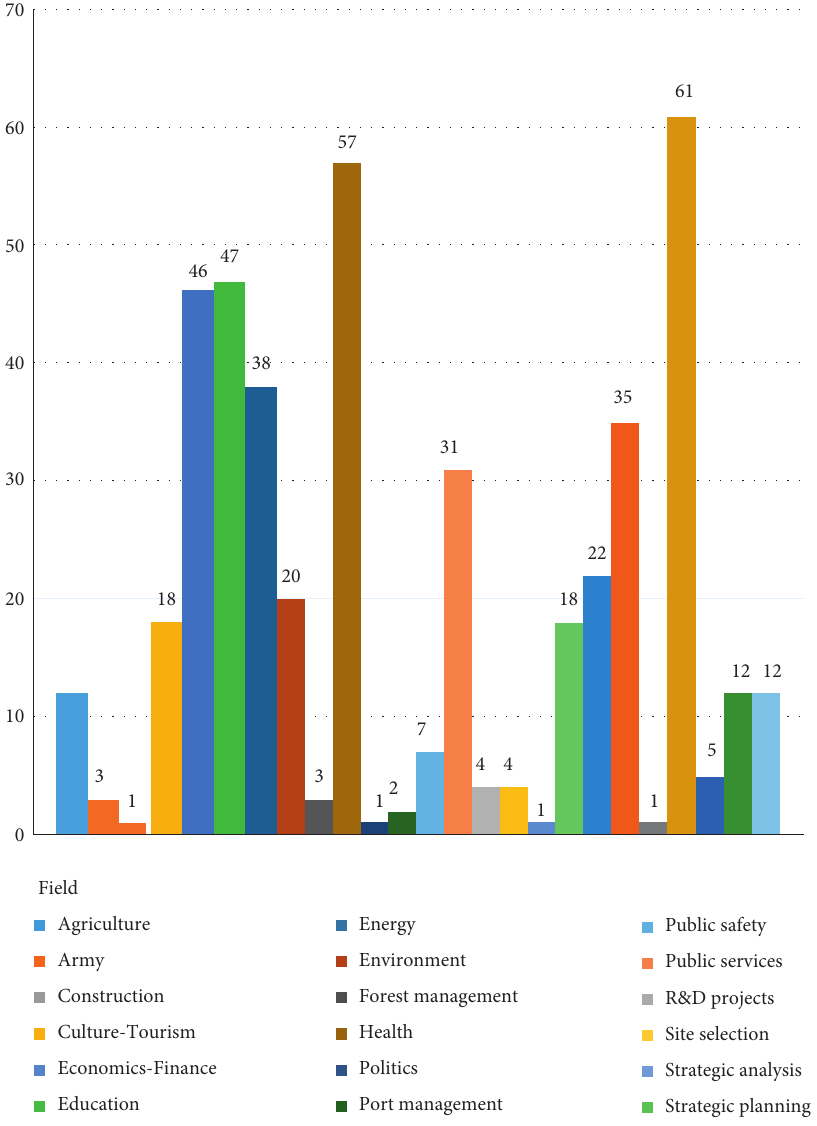
Figure 5: Distribution per